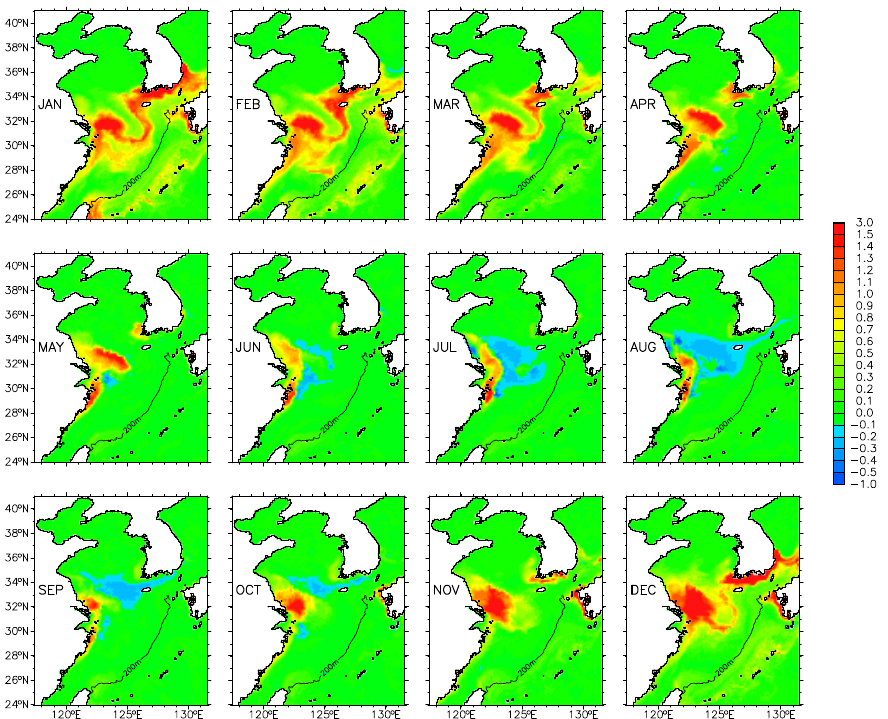
Fig. 12. Anomaly of monthly DIN (mmolm − 3 ) in the surface layer (2m depth) between the sensitivity experiment, in which the oceanic nutrients were enriched by 30%, and the control